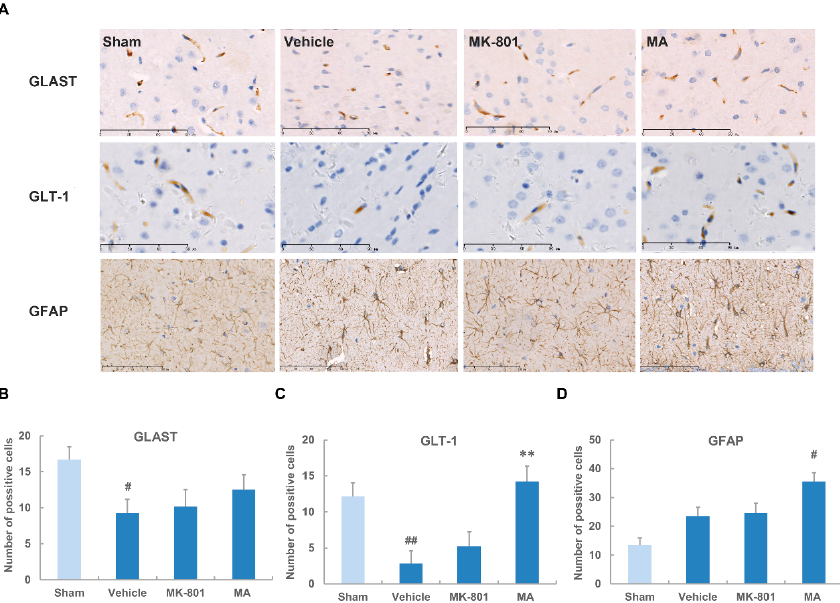
Figure 4. Maslinic acid increases the expression of glial glutamate transporters after cerebral ischemia. ( A ) The expression of GLAST, GLT-1 and GFAP was determined by immunohistochemistry following 2 h of ischemia and 70 h of reperfusion. Maslinic acid (0.4 μ g/mL) was administered 15 min before MCAO. MK-801 (0.5 mg/kg) was given at 3 h after MCAO; The expression of ( B ) GLAST; ( C ) GLT-1; and ( D ) GFAP was quantitatively represented as the positive-cell number in one field. Data were expressed as means ± SEM from three independent animals containing three randomly selected fields. # p < 0.05, ## p < 0.01 versus the sham group; ** p < 0.01 versus the vehicle group. Scale bar: 90 μ m.